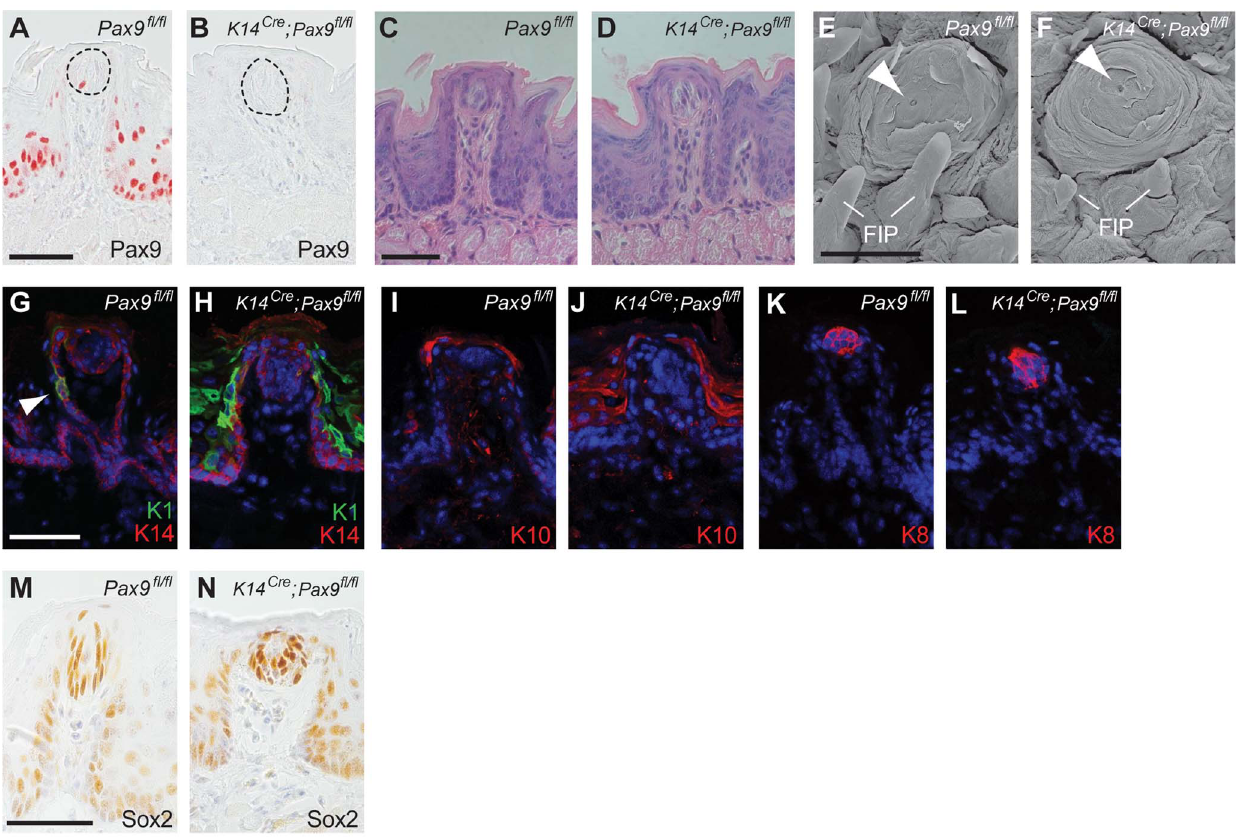
Figure 3. FUP maintenance and FUP taste bud renewal do not require Pax9 functions. All analyses were carried out using 3–5 months old mice. ( A,B ) Pax9 immunostaining of FUPs. In Pax9 fl/fl mice (A), Pax9 expression is detected in the FUP epithelium and in isolated taste bud cells (area of taste bud is indicated by dotted line). (B) No Pax9-positive cells are detectable in the FUP after K14 Cre -mediated recombination of Pax9 fl/fl . ( C,D ) Histological sections of FUP. Pax9 fl/fl FUP (C) and K14 Cre ; Pax9 fl/fl FUP (D) are morphologically indistinguishable. ( E,F ) Scanning electron microscopy images of FUP. The FUP of both Pax9 fl/fl (E) and K14 Cre ; Pax9 fl/fl (F) form taste pores (arrowhead), whereas the non-sensory FIP of the mutants (F) are hypoplastic. ( G–L ) Indirect immunofluorescent detection of keratins. Nuclei were stained with DAPI (blue). (G) In Pax9 fl/fl mice, K14 is expressed in basal cells of the epithelium and K1 expression was seen in isolated epithelial cells of the FUP epithelium (arrowhead). (H) While K14 expression was not affected in the FUP of K14 Cre ; Pax9 fl/fl mice, the number K1 expressing cells was strongly increased. ( I,J ) K10 expression is mainly restricted to the apical end of the FUP in Pax9 fl/fl mice (I) whereas its expression is more extended in K14 Cre ; Pax9 fl/fl mice (J). ( K,L ) K8 expression marks taste bud cells in both genotypes. ( M,N ) Immunohistochemical staining showing that Sox2 is expressed in mature taste buds of both Pax9 fl/fl (M) and K14 Cre ; Pax9 fl/fl (N) mice. Scale bars: 50 m m in A,C,G,M; 500 m m in E.